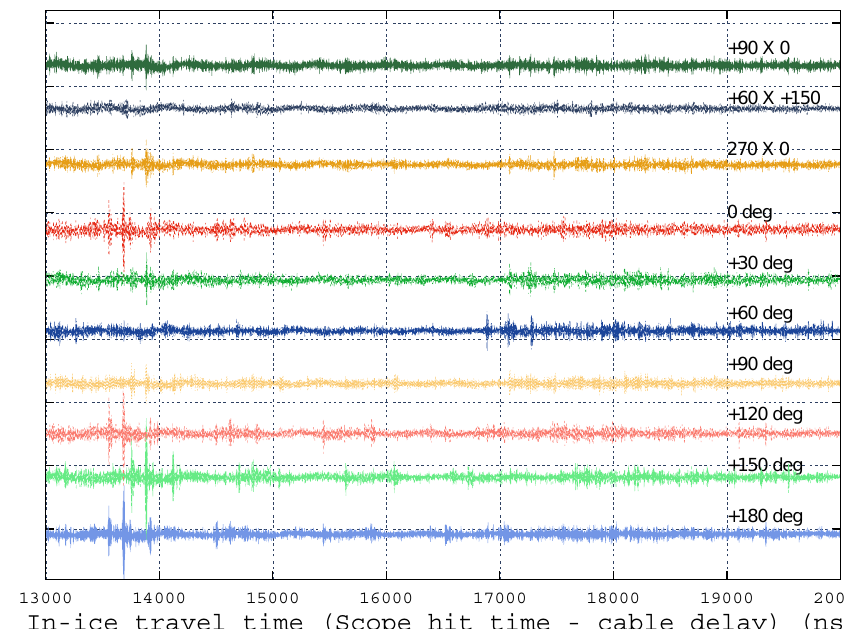
Fig. 4. Ensemble of echo amplitudes observed as a function of azimuthal orientation, for both co-polarized and cross-polarized broadcast signals, for echo times between 13µs and 20µs. A DC offset has been added vertically to successive voltage traces for visual clarity; alternate waveforms are similarly also offset by ± 100ns along horizontal. Each division vertically corresponds to 1mV.